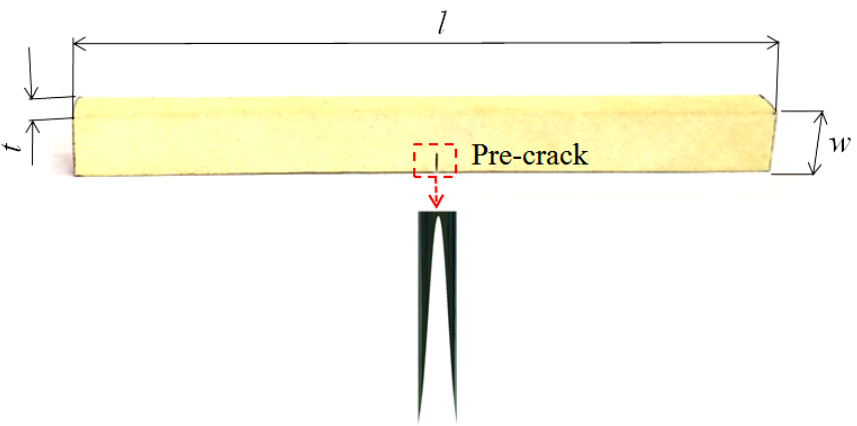
Figure 2. A standard three-point bending specimen for fracture test.